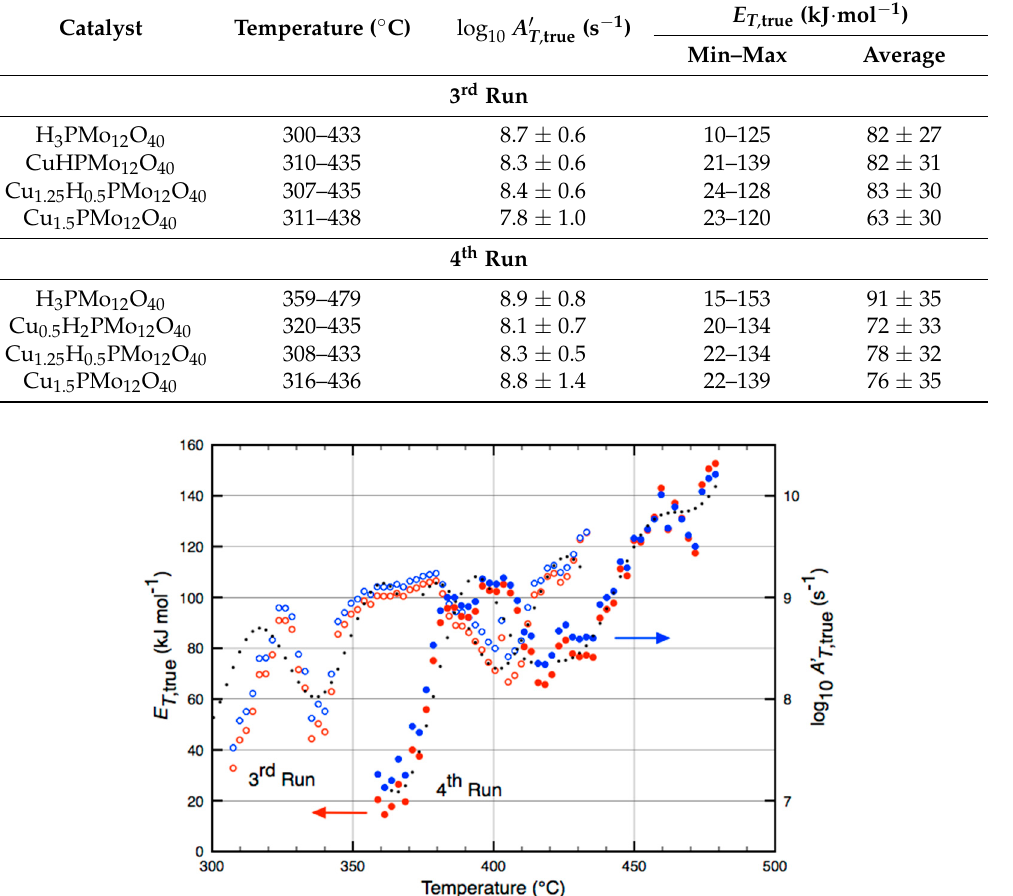
(cid:1827) (cid:3021),(cid:2930)(cid:2928)(cid:2931)(cid:2915)(cid:4593) (blue circles) A (cid:48) (blue circles) T ,true 10 10